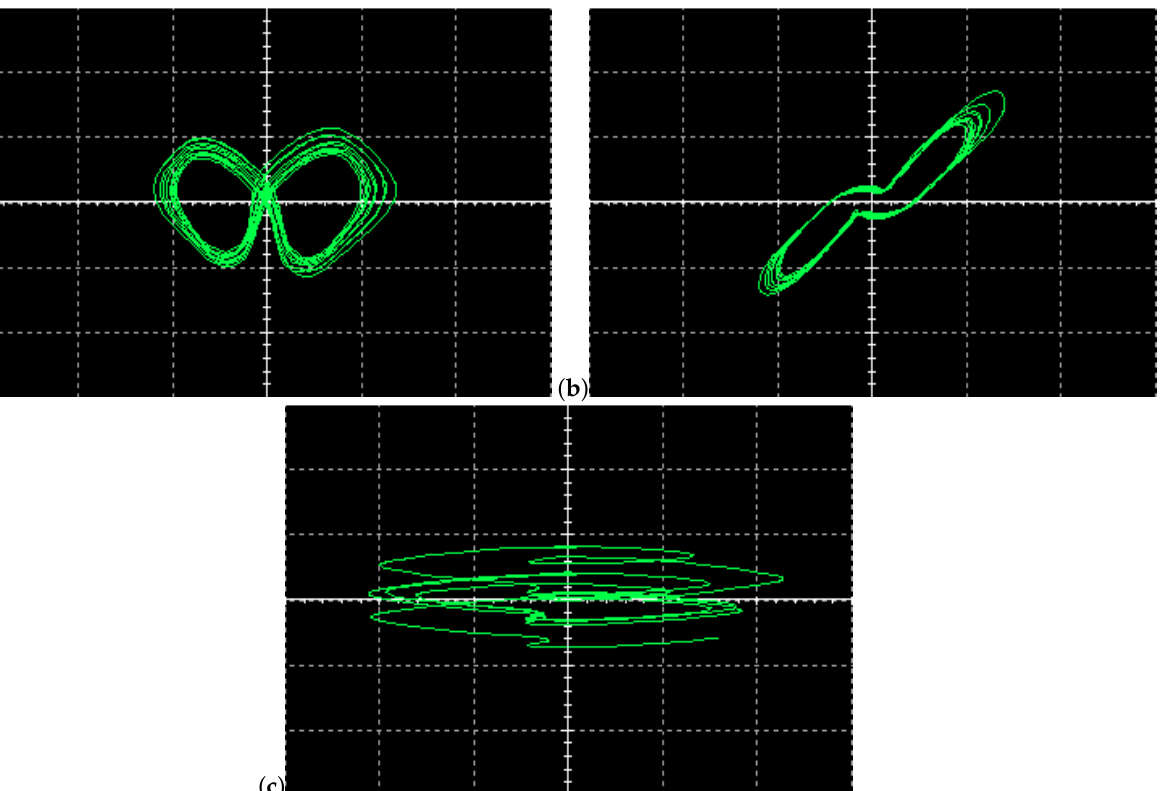
Figure 20. Two-dimensional phase portraits of the new system in Multisim of the circuit with a = 10, b = 100, c = 2.7, k = − 0.2, and m = 1: ( a ) X – Z plane; ( b ) X – Y plane; ( c ) Y – W plane.